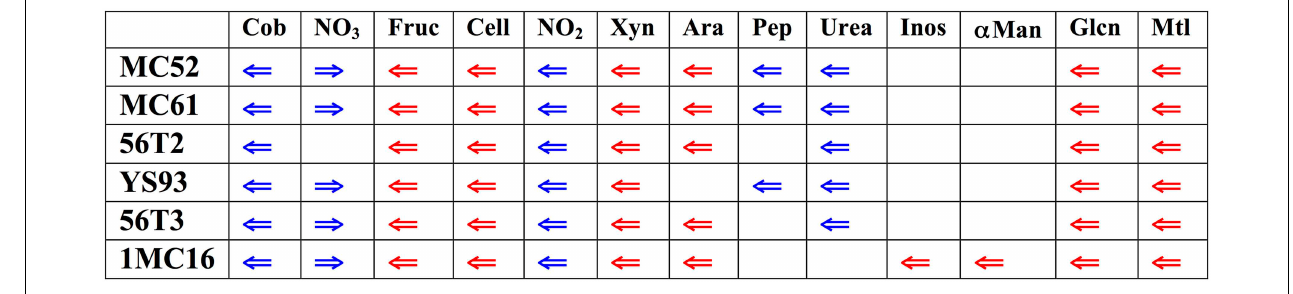
FIGURE 2 | Diagram of major functional clusters found in the conserved regions; carbohydrate utilization clusters are shown in red, non-carbohydrate clusters in blue. Cob, cobalamin biosynthetic cluster, NO 3 , nitrate reductase cluster; Fruc, fructose utilization cluster; Cell, cellobiose utilization cluster; NO2 3 , nitrite reductase cluster; Xyn, xylose and xylan utilization cluster; Ara, arabinose and arabinan utilization cluster, and ribose transporter cluster: Pep, peptide utilization cluster;